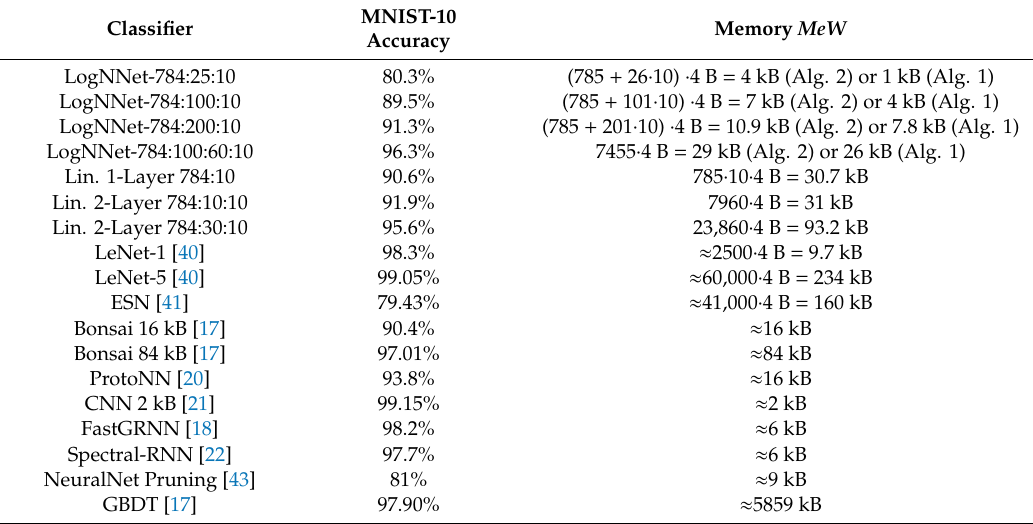
Table 1. Comparison of LogNNet network with other machine learning approaches. For all LogNNet configurations r = 1.885, A = 0.3, B = 5.9.